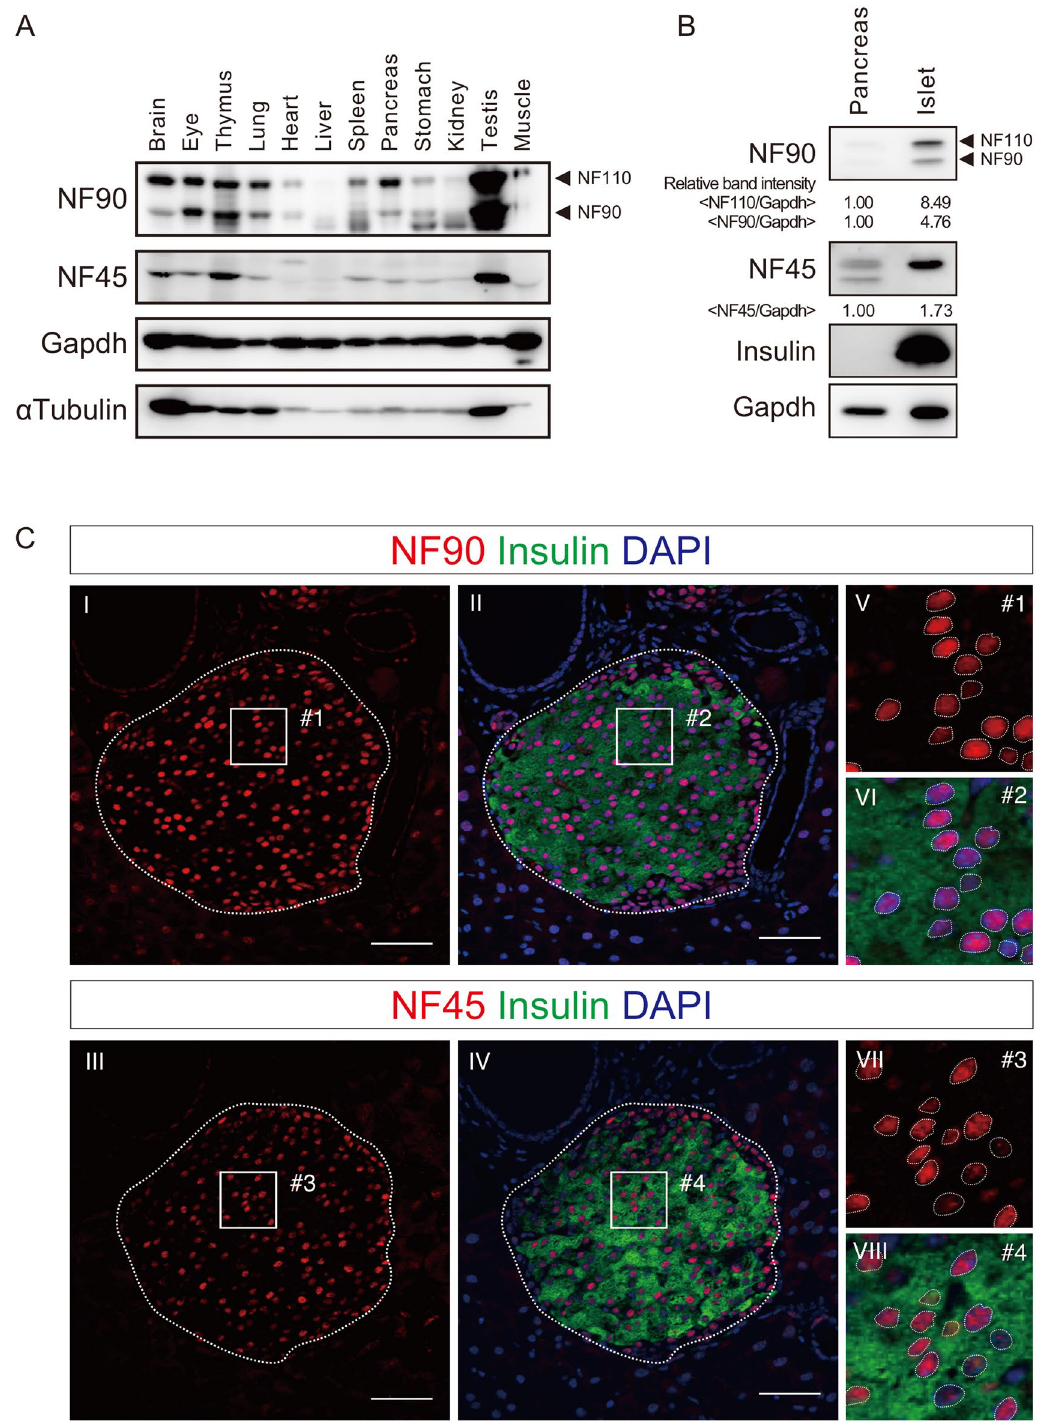
Figure 1. NF90 family and NF45 is expressed in pancreatic β cells. ( A ) Expression levels of NF90 family and NF45 were examined in mice tissues by western blot. Gapdh and α Tubulin was used as an internal control. Experiment is representative of n = 3 mice tissues. ( B ) Western blot analysis of levels of NF90 family and NF45 in pancreas or isolated islet from wild-type mice. Insulin and Gapdh was used as an islet marker and an internal control, respectively. Intensities of specific bands was measured by densitometry. Gapdh was used for normalization of data. Experiment is representative of n = 3 mice pancreas and n = 6 mice islets. ( C ) Immunofluorescence staining of NF90 family (red, panels I, II, V and VI) and NF45 (red, panels III, IV, VII and VIII) in pancreas section of wild-type mice. Insulin (Green) and DAPI (Blue) was shown as β cells and nuclei, respectively. Bar, 50 µm. In panels I to IV, an islet was shown as a dash-line. Higher magnifications of #1 to #4 in panels I to IV were presented in panels V to VIII. In panels V to VIII, a nucleus was shown as a